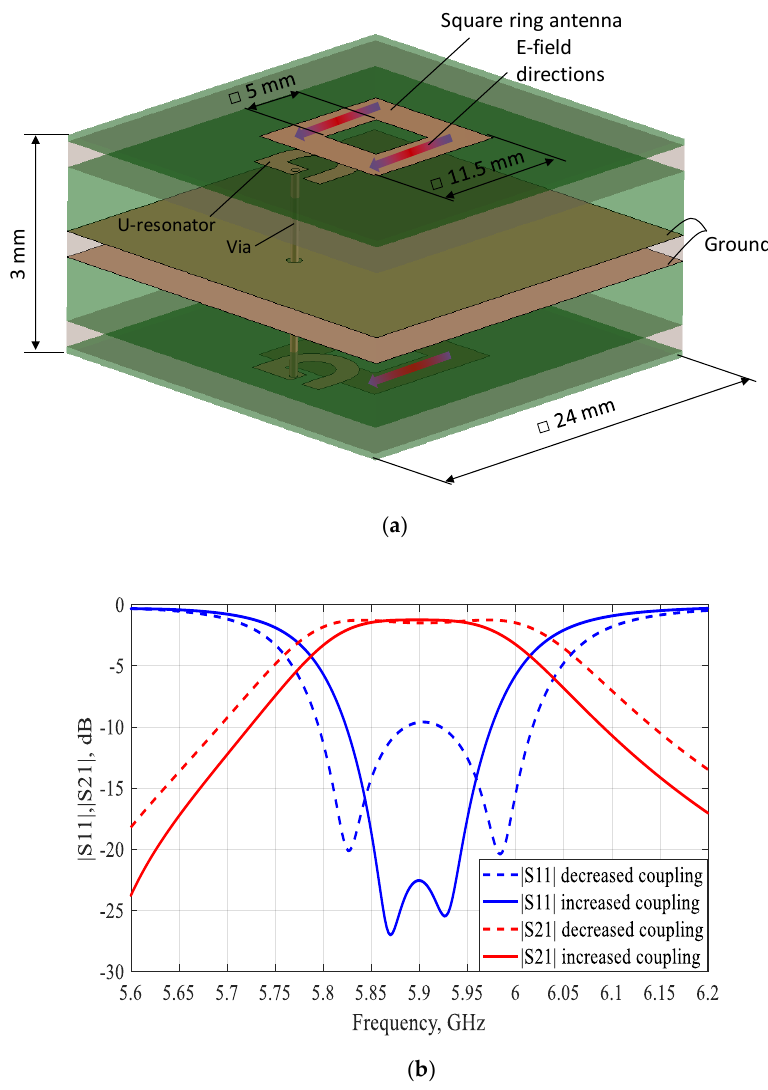
Figure 1. Non-reconfigurable unit cell structure ( a ), and EM simulation results of the unit cells scattering parameters modules for different coupling between patch antennas ( b ).